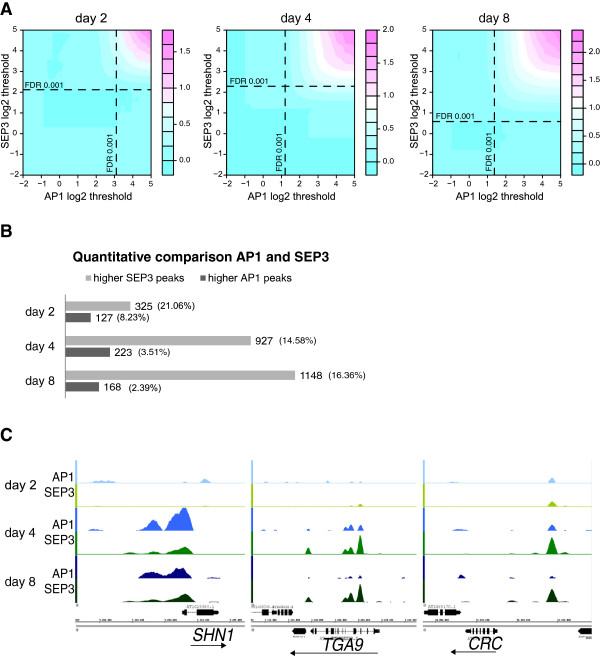
Overlap and differences between AP1 and SEP3 DNA binding. (A) Overview of AP1 and SEP3 common target genes obtained from the ChIP-seq datasets at the same time points. The figure shows the ratio between the observed number of common target genes divided by the expected number when the location of AP1 and SEP3 BSs are independent, this expected number was estimated by multiplying the proportion of AP1 BSs by the proportion of SEP3 BSs and by the total number of BSs. The x-axis and y-axis represent the threshold values for declaring a given region as significantly bound by AP1 and SEP3, respectively. (B) Changes in AP1 and SEP3 binding at common time points. ‘Higher AP1 peaks’ are genomic regions with AP1 peaks that are at least two-fold higher than the SEP3 peaks, while ‘higher SEP3 peaks’ are genomic regions with AP1 peaks at least two-fold lower than the SEP3 peaks. Only significant peaks (FDR <0.001) located in a region comprising 3 kb upstream and 1 kb downstream of a gene are considered. (Additional file 2: Table S2). (C) AP1 and SEP3 binding profiles for selected target genes. SHINE 1 (SHN1) is an example of an AP1 target gene that is most strongly bound at day 4, whereas TGA9, a gene involved in anther development, and CRC, a gene involved in carpel development, are preferentially SEP3 targets.